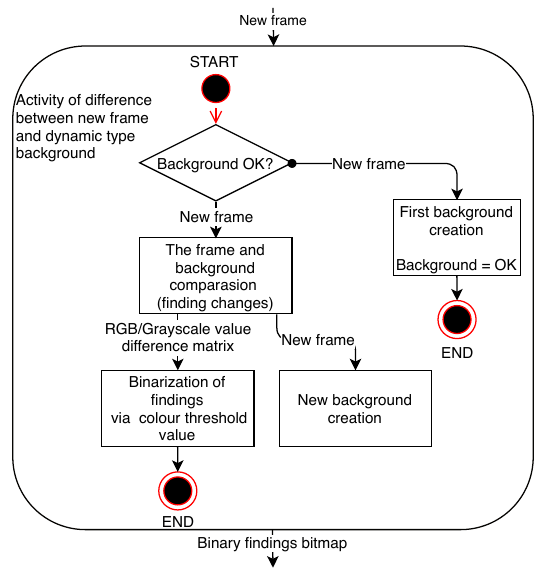
Figure 9. Diagram of the difference method activity of the current frame towards the dynamic